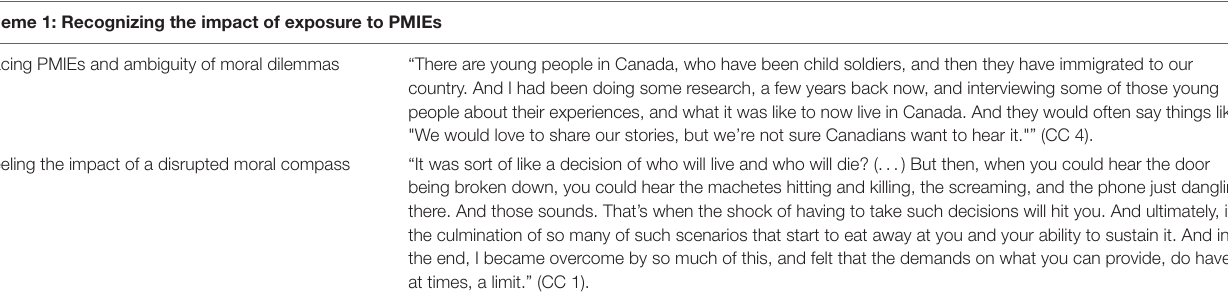
TABLE 3 | Additional supporting quotes for the theme “Recognizing the impact of exposure to potentially morally injurious events (PMIEs).” Theme 1: Recognizing the impact of exposure to PMIEs Facing PMIEs and ambiguity of moral